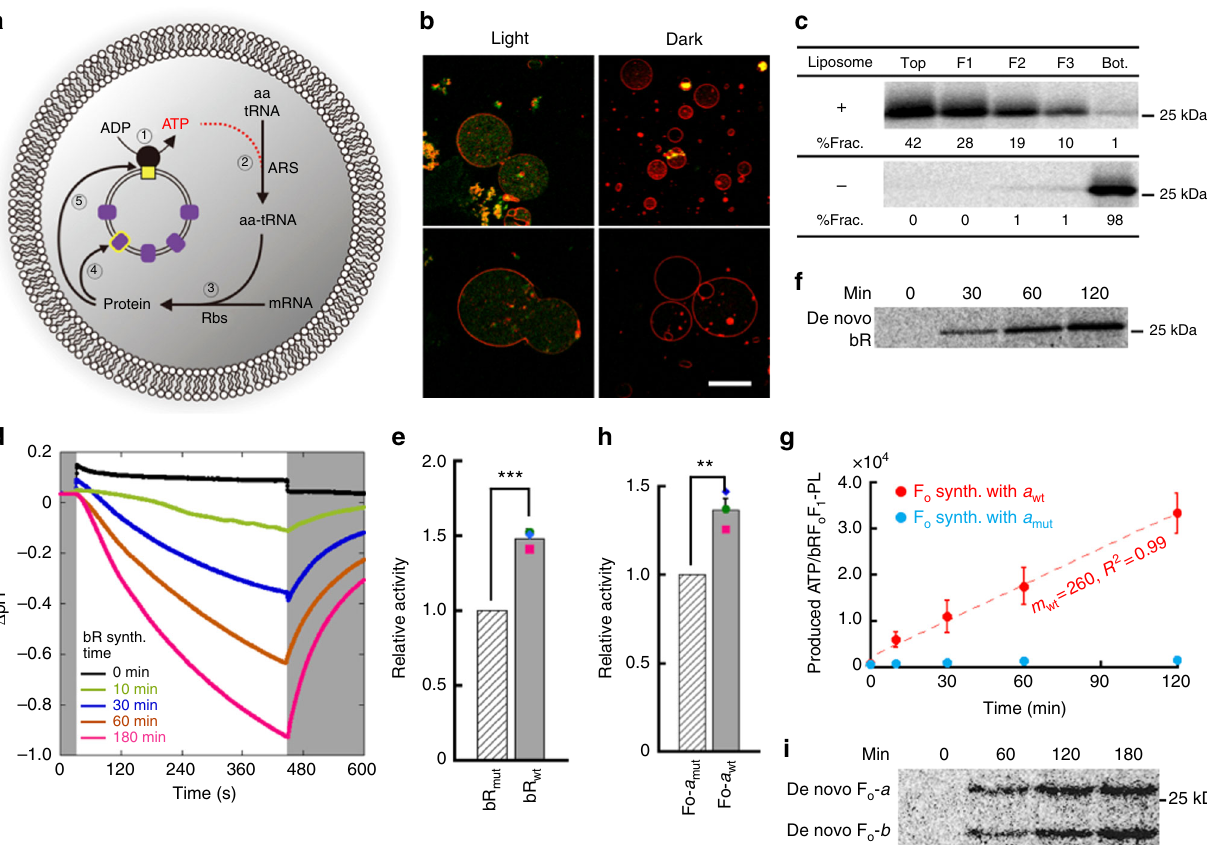
Fig. 3 Self-constituting protein synthesis in arti fi cial photosynthetic cells. a Schematics of self-constituting protein synthesis. The numbers indicate the order of reactions; ➀ : adenosine triphosphate (ATP) synthesis, ➁ : aminoacylation of transfer RNA (tRNA) by aminoacyl-tRNA synthetase (ARS), ➂ : translation by ribosomes (Rbs), ➃ : de novo bacteriorhodopsin (bR) synthesis, and ➄ : de novo F o synthesis. b Light-induced bR-GFP synthesis in giant unilamellar vesicles (GUVs). Bar: 10 µ m. c Membrane localization of bR. The bRs synthesized in the PURE system with or without liposomes were fractionated by ultra-centrifugation with sucrose cushion. The percentages of bR in each fraction (%Frac.) are indicated at the bottom of the gels. d Proton- pump activity of bR synthesized in the PURE system. The measurement was performed as in Fig. 1c. The reaction times of protein synthesis are indicated by different colors. The white and gray areas represent light ON and OFF, respectively. e Enhanced arti fi cial organelle by de novo bR. Wild-type (bR wt ) or mutant (bR mut ) bRs were photosynthesized in the PURE system containing bRF o F 1 -PLs. The ATP concentrations at the time 2 h was measured and converted into ATP per proteoliposome (PL). The value of the de novo bR wt -containing PL was normalized to that of the de novo bR mut -containing